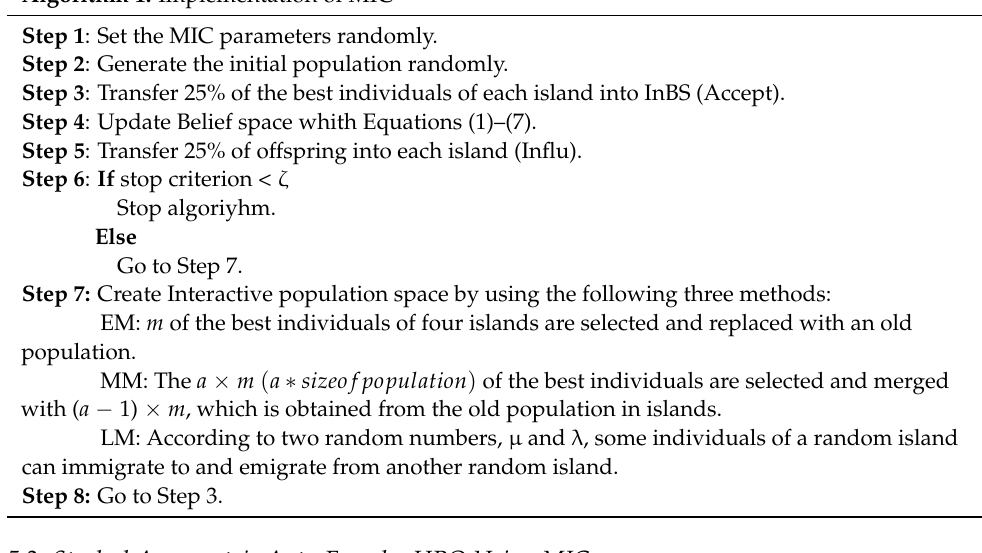
Algorithm 1: Implementation of MIC